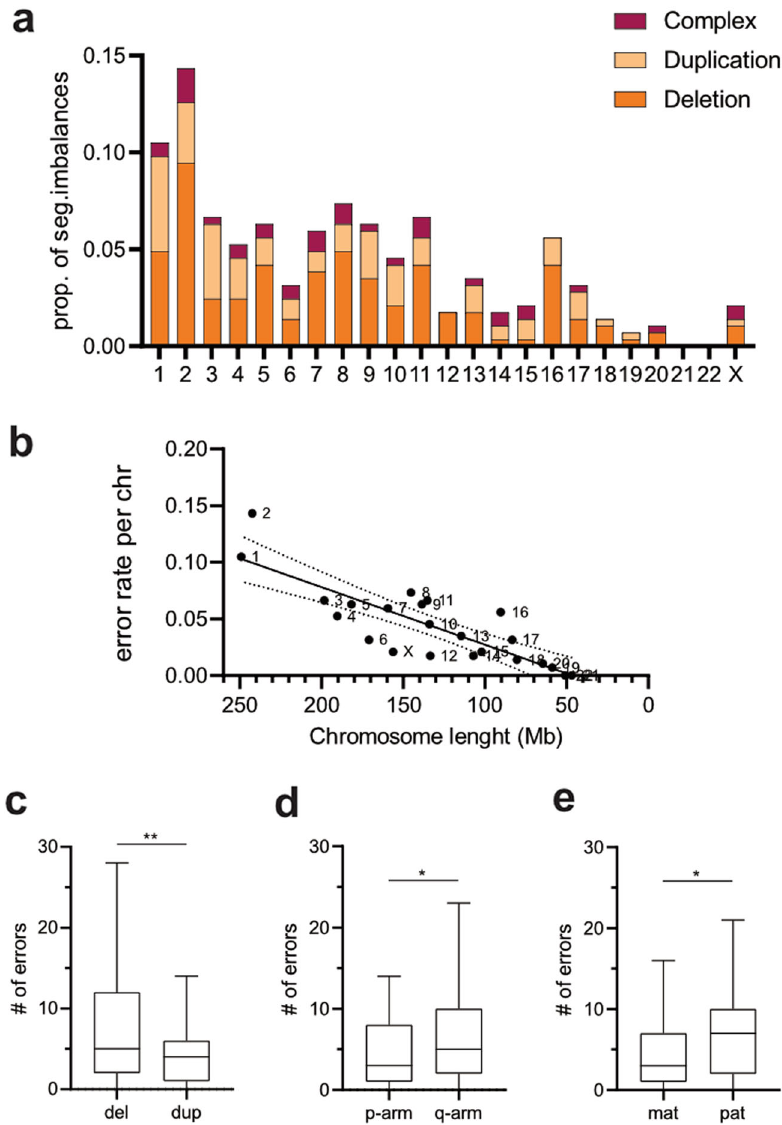
Fig. 4 Segmental imbalances in cleavage embryos. a Rate and distribution of various types of segmental imbalances across the genome ( n = 162, 91, and 41 for deletions, duplications and complex imbalances, respectively). b Correlation of chromosome-speci fi c rate of segmental imbalances with chromosome length ( R 2 = 0.69, P < 0.0001). Boxplot comparison of simple segmental imbalances ( n = 253) by nature (deletions vs. duplications) ( c ), location (p-arm vs. q-arm) ( d ) and parental origin (maternal vs. paternal) ( e ). Two-tailed t -test, ** P = 0.008, * P =